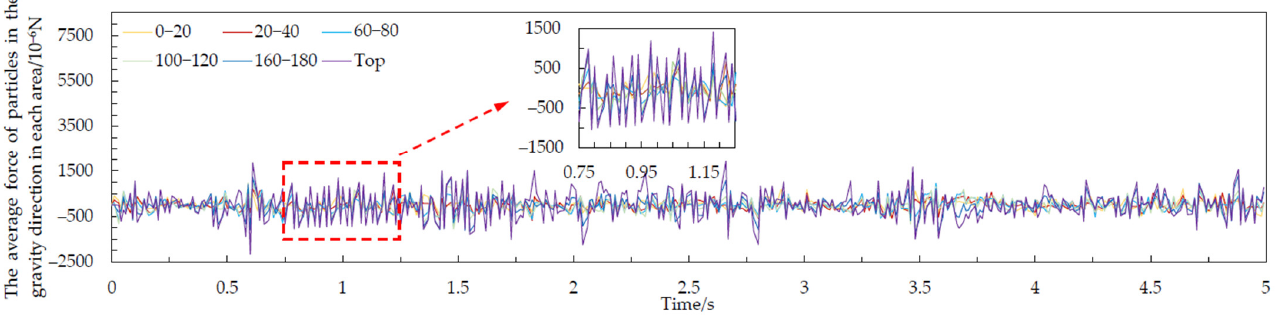
Figure 8. Average velocity and standard deviation of corn grain in each area over 0–5 s.